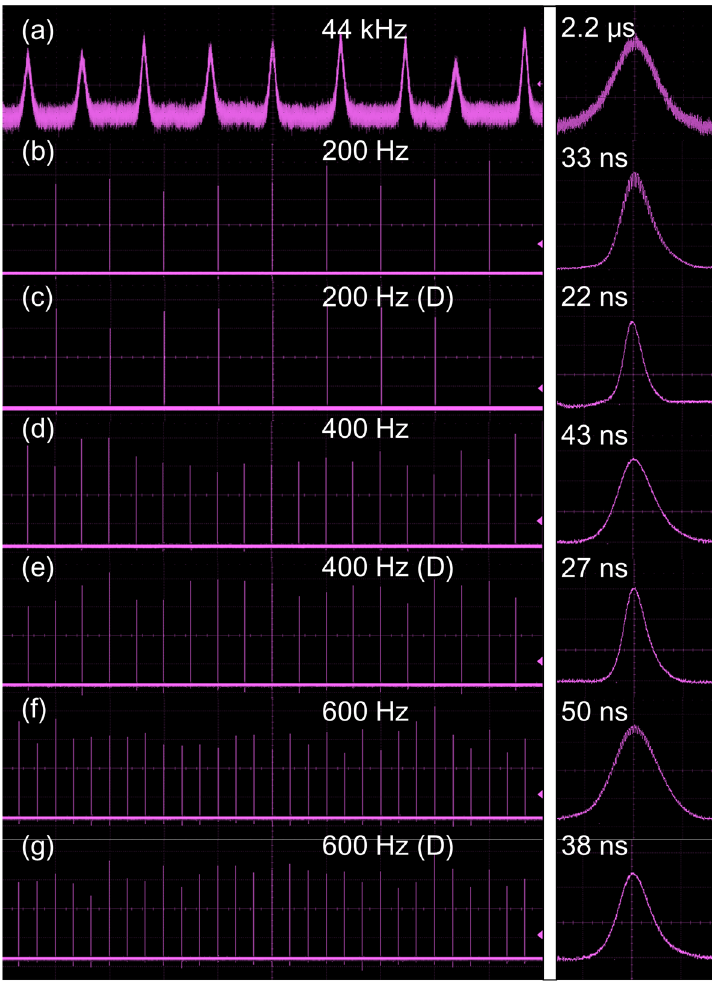
Figure 8. Q-switched temporal pulse sequences and single pulse profiles at pump power of 6.87 W. (a) VS 2 Q-switched laser, (b,d,f) EOM Q-switched lasers at 200, 400, and 600 Hz, (c,e,g) doubly Q-switched lasers at 200, 400, and 600 Hz.